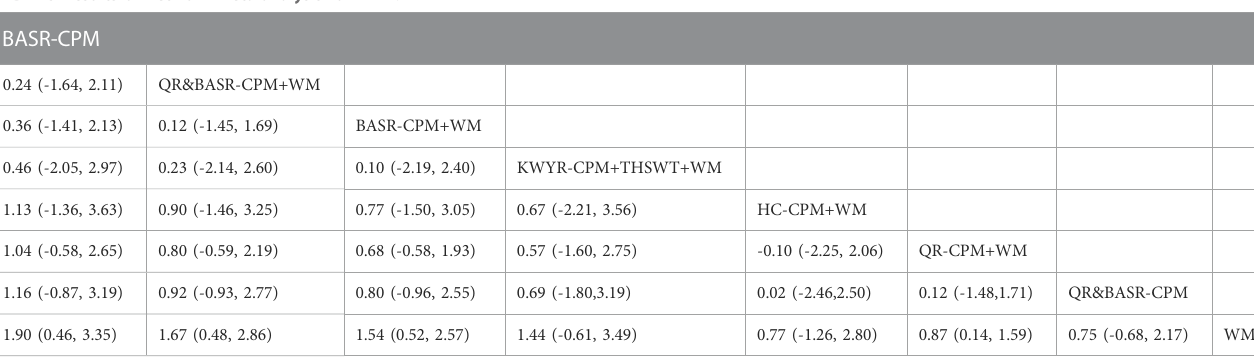
TABLE 5 Results of network meta-analysis for